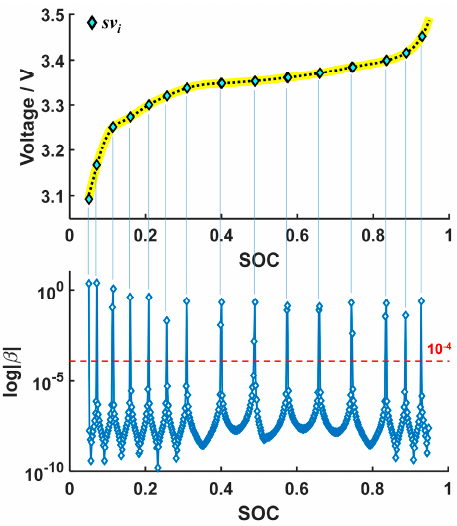
Figure 3. The selection of support vector with significant coefficient β , for Battery A, σ = 0.06, D = 100.